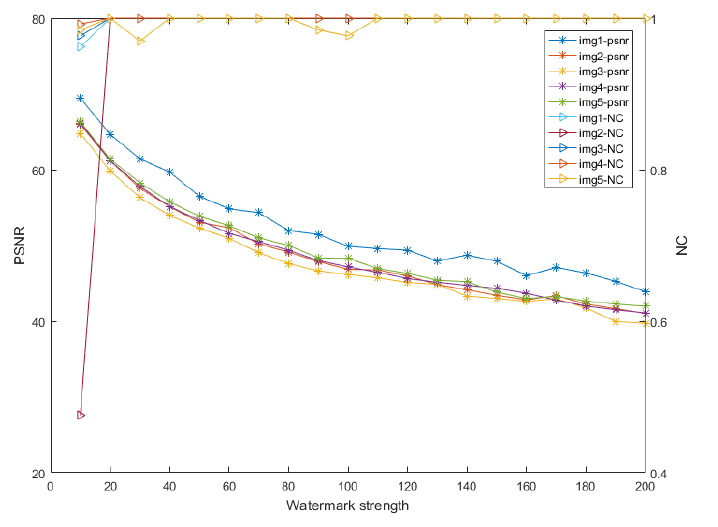
Figure 6. PSNR and NC of the five watermarked images with different watermark strengths.